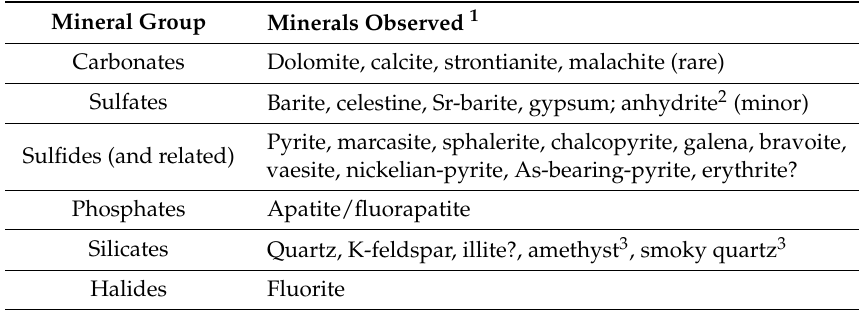
Table 2. Complete list of Mississippi Valley-type and associated diagenetic minerals observed in Paleozoic rocks of northeastern